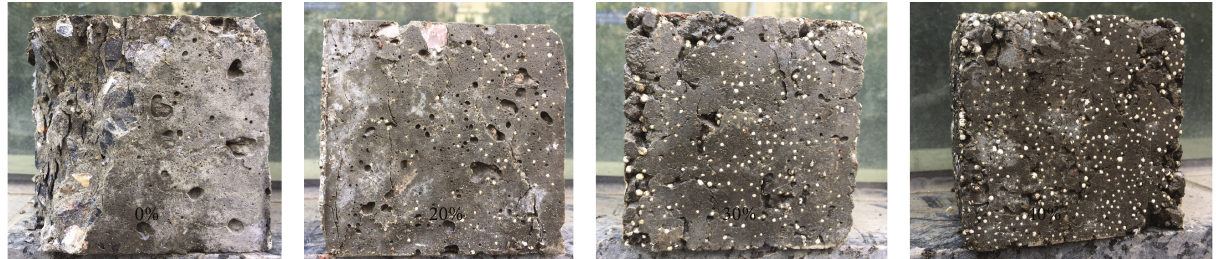
Figure 7: Failure mode of the EPS concrete with different EPS particles volume ratio.